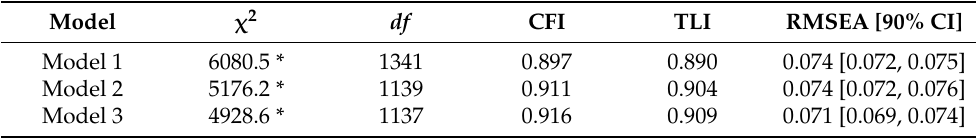
Table 1. Results of a confirmatory factor analysis.